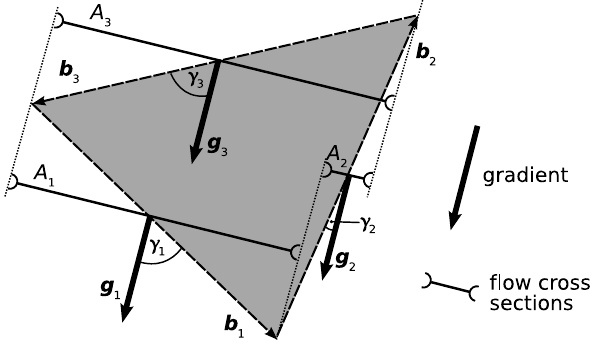
Fig. 2. Scheme for derivation of flow cross sections. This figure shows a triangle which is surrounded by other triangles lying in the same plane.